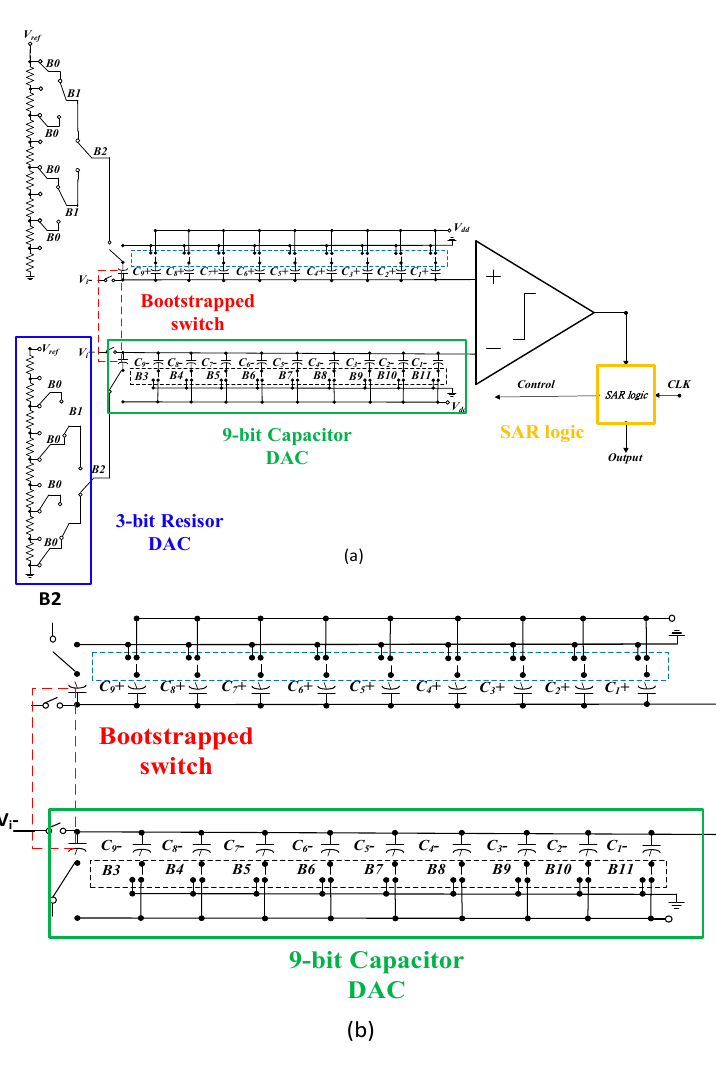
Figure 8. ( a ) The topology of the 12-bit SAR ADC; ( b ) a bootstrapped and partial DAC of the ADC.